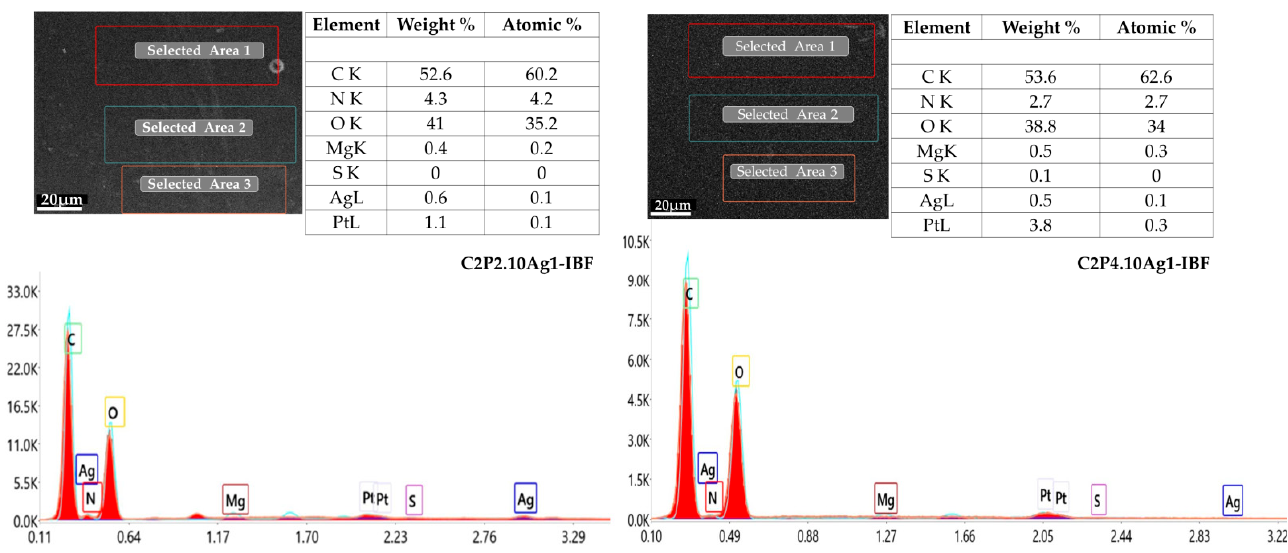
Figure 6. EDAX spectrum of composite films (scale bar-20 µ m).